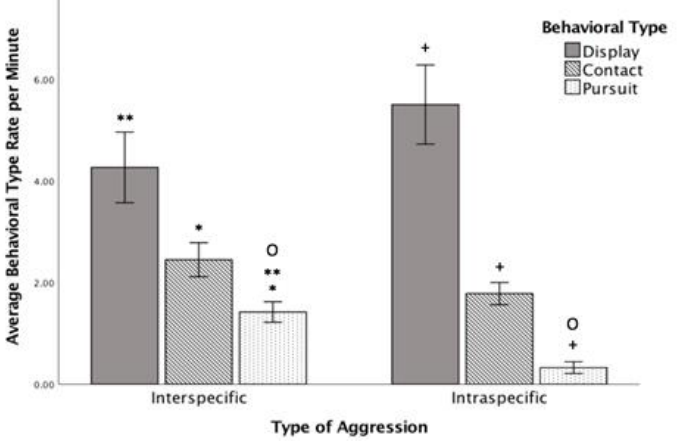
Mean Rate per Minute that each Behavioral Type was Used During both Interspecific and Intraspecific Aggression